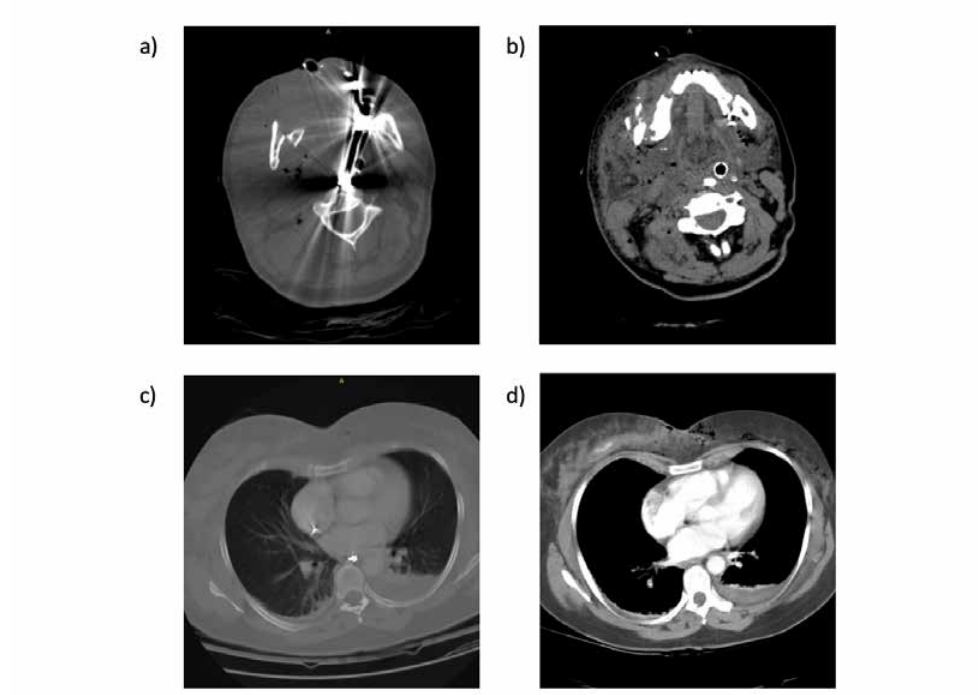
Figure 2 a-d: Mandibular fragments, teeth and teeth restoration fragments as well as the respiration tube in the perimandibular region, and the completely swollen pharynx (a and b). Teeth fragments in the esophagus, as well as a small pleural effusion (c), and active extravasation in a projectile trajectory within the right mamma